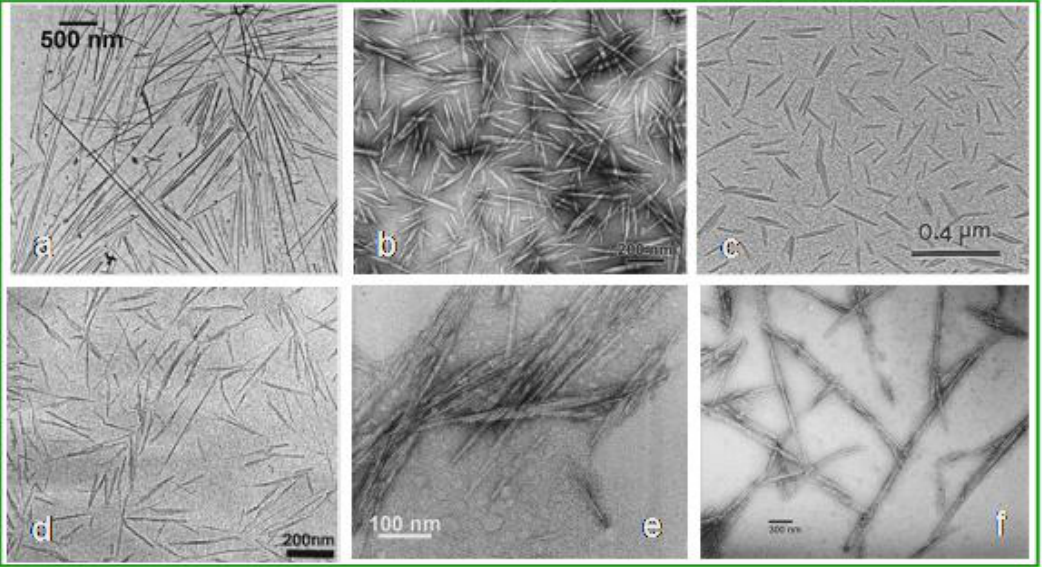
Figure 4. Transmission electron micrographs from diluted suspensions of hydrolyzed ( a ) tunicin [74], ( b ) ramie [36], ( c ) cotton [57], ( d ) sugar beet [73], ( e ) MCC [75], and ( f ) bacterial cellulose